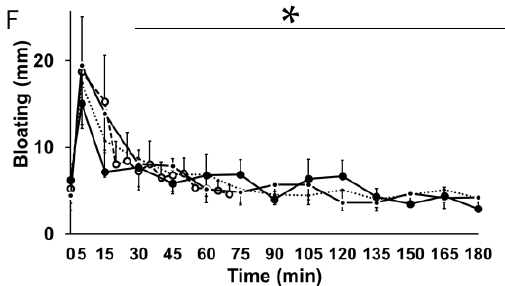
Figure 3. Visual analogue score (VAS, mm) of hunger (A), desire to eat (B), prospective food consumption (C), fullness (D), nausea (E), and bloating (F; n = 13 healthy young men), after ingestion of a control drink (450 mL; ~2 kcal/‘control’) or iso-volumetric drinks containing protein/carbohydrate/fat: (i) 14 g/28 g/12.4 g (280 kcal/‘M 280 ′); (ii) 70 g/28 g/12.4 g (504 kcal/‘M 504 ′); or